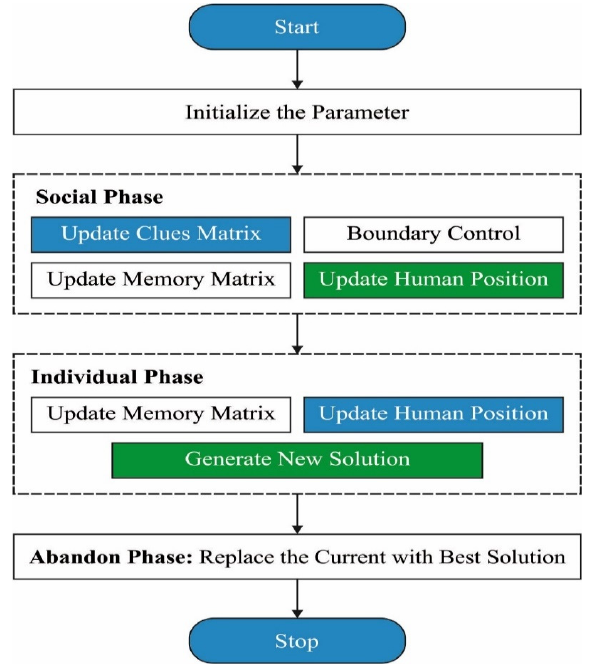
Figure 2. Flowchart of